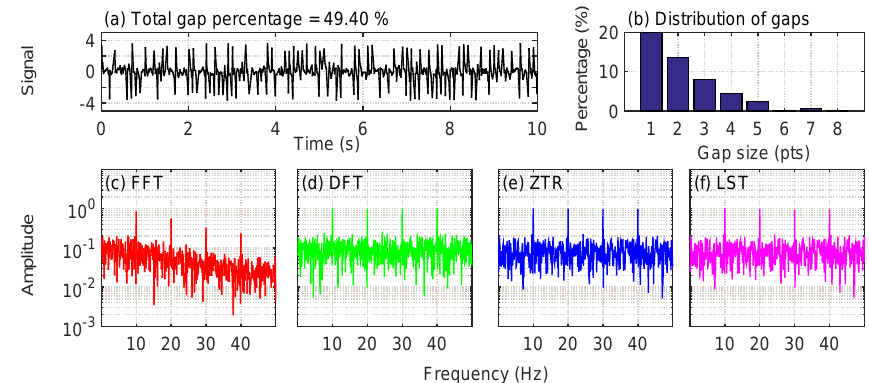
Figure 7. Case study for the MSG test applied to the synthetic data. The format is similar to Fig. 2 and 3, except for panel (b) , which shows the individual gap percentage as a function of gap size corresponding to this case study.